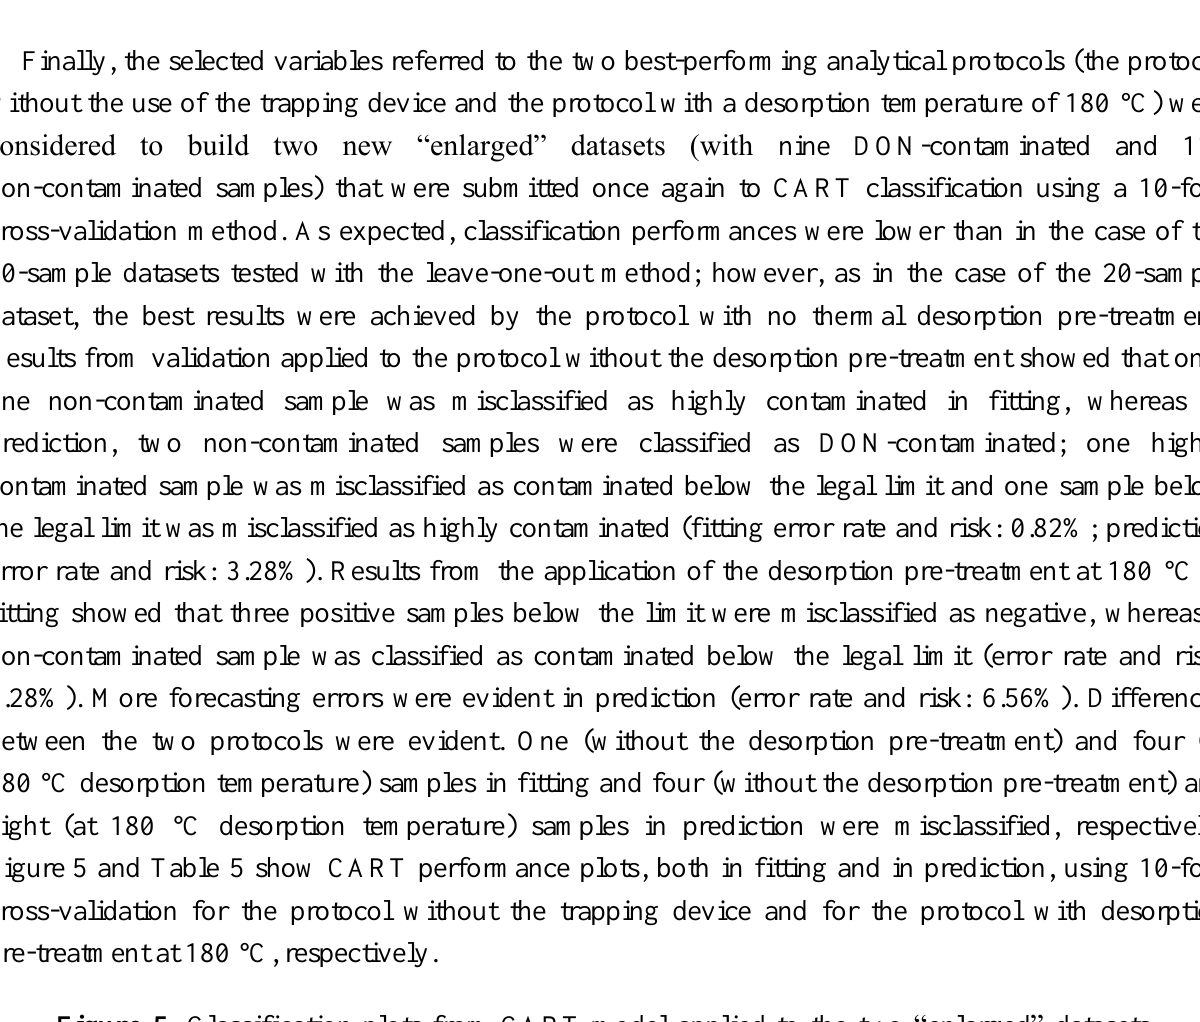
Figure 5. Classification plots from CART model applied to the two ―enlarged‖ datasets. Blue dots: samples classification in fitting; Red dots: samples classification in prediction (using 10-fold cross-validation). (a) protocol without the trapping device; (b) protocol with desorption pre-treatment at 180